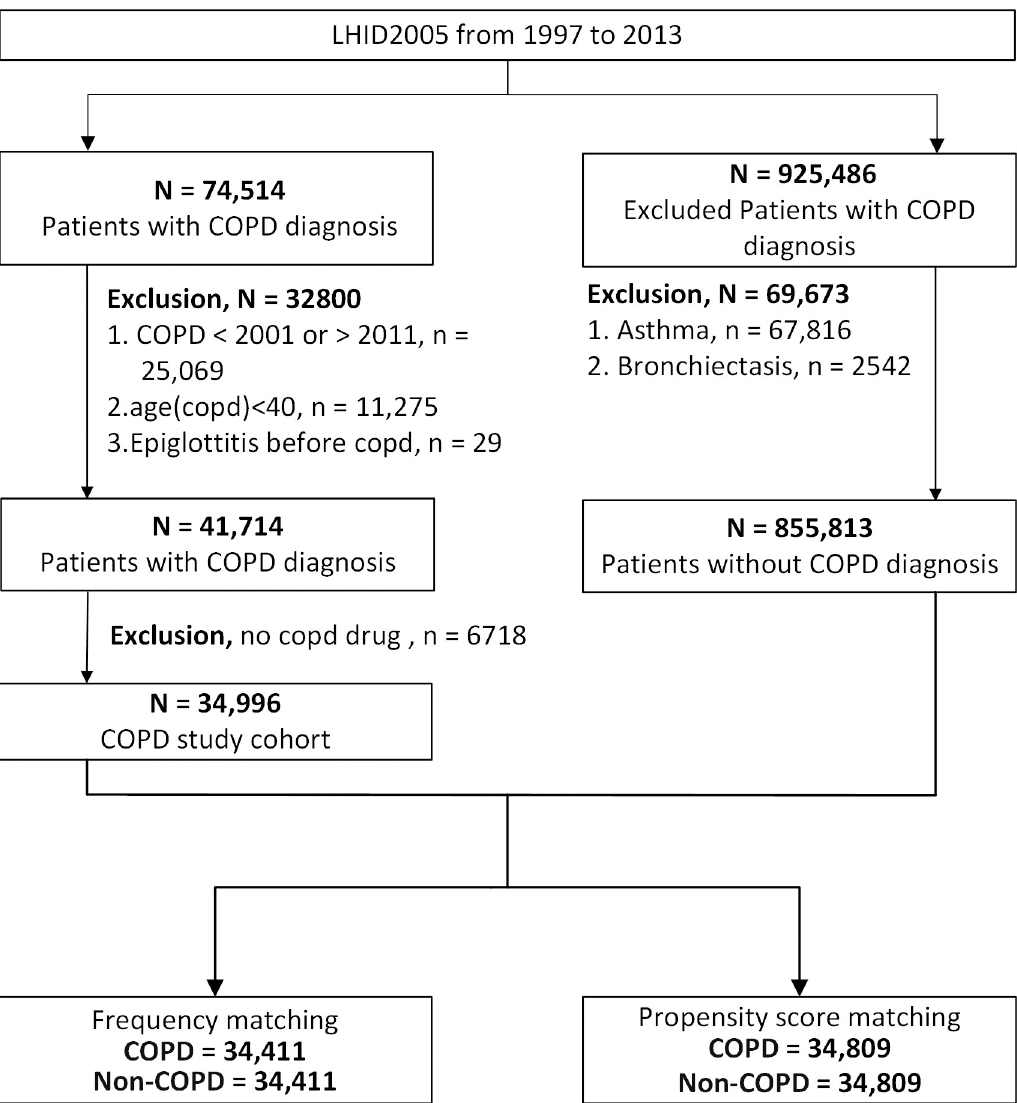
Fig 1. Schematic of the participant enrollment process in this study. Abbreviations: COPD, chronic obstructive pulmonary disease; LHID2005, Longitudinal Health Insurance Database 2005.